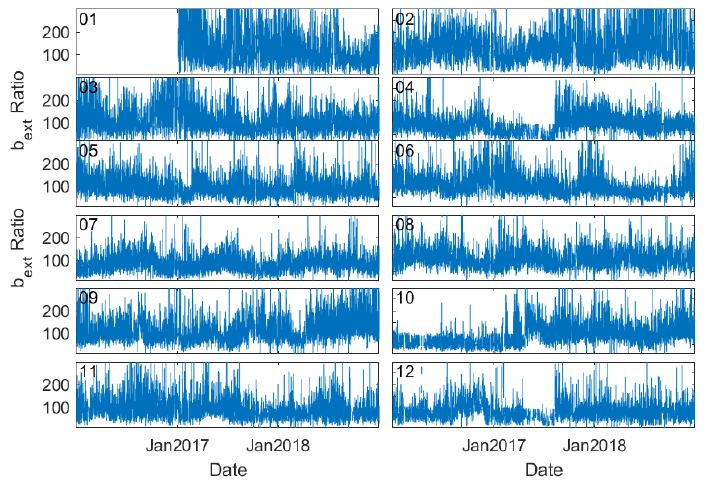
Figure 9. The relationship between PM 2.5 and b ext at Yangzhou, Jiangsu Province based on original and corrected measurements ( a , b ); the time series of PM 2.5 and b ext ( c ) and the ratio of b ext to PM 2.5 , i.e., α ext ( d ).